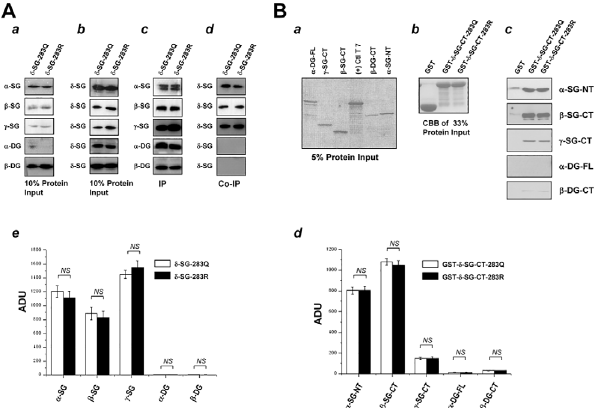
Fig 5. Comparison of δ -SG-283Q and δ -SG-283R on the interaction to other five DGC components. Fig 5 A compares IP and Co-IP results between δ -SG-283Q and δ -SG-283R. In HEK293T cells, full-length δ -SG- 283Q or δ -SG-283R was separately co-expressed with full-length α -SG, β -SG, γ -SG, α -DG, and β -DG. Then the cell were harvested and checked by WB for expression of each protein ( a , b ), IP ( c ), and Co-IP ( d ). A statistic summary of arbitrary unit of density (AUD) from 4 independent assays was shown ( d ). Fig 5 B compares pull-down results between GST- δ -SG-CT-283Q and GST- δ -SG-CT-283R. 10% 35 S-methionine- labeled protein input of α -SG-NT, β -SG-CT, γ -SG-CT, α -DG-FL, and β -DG-CT shown by autoradiography ( a ) and 33% protein input of GST, GST- δ -SG-CT-283Q, and GST- δ -SG-CT-283R shown by CBB staining ( b ) were used in the pull-down assay ( c ). The bound α -SG, β -SG, γ -SG, α -DG, and β -DG to GST- δ -SG-CT-283Q or to GST- δ -SG-CT-283R was compared by WB ( c ) with a statistic summary of AUD from 4 independent pull- down assays ( d ).